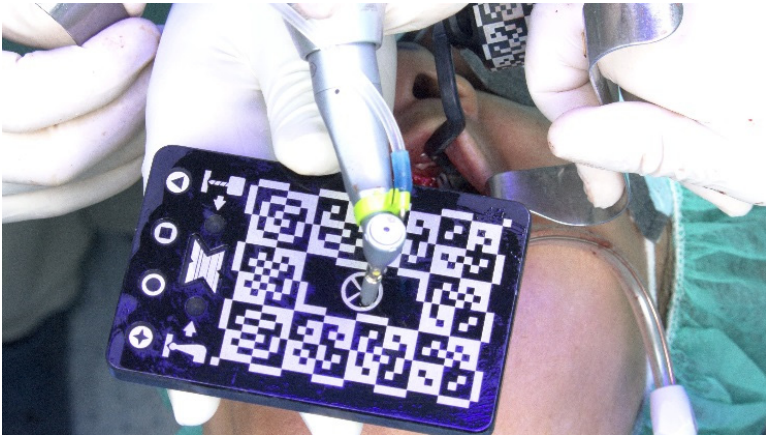
Figure 12. Spatial calibration of the dental implant using an array immediately before insertion.